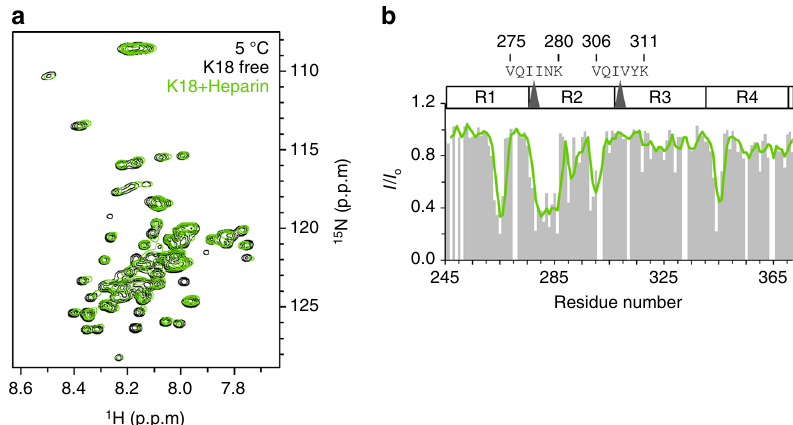
Fig. 7 Heparin binds to the dispersed K18 monomer at 5 °C. a 2D 1 H- 15 N HSQC spectrum of K18 (100 μ M) in the absence ( black ) and presence ( green ) of heparin (K18:heparin molar ratio of 4:1) recorded at 5 °C. b Residue-speci fi c changes in NMR signal intensity demonstrate binding of heparin to K18; however, no fi brils were formed despite incubation for 3 days (Fig. 6f). Signal intensities in the absence ( I 0 ) and presence of heparin ( I ) were taken from a . The green line shows the 3-residue average of I / I 0 . Aggregation prone hexapeptide sequences in R2 and R3